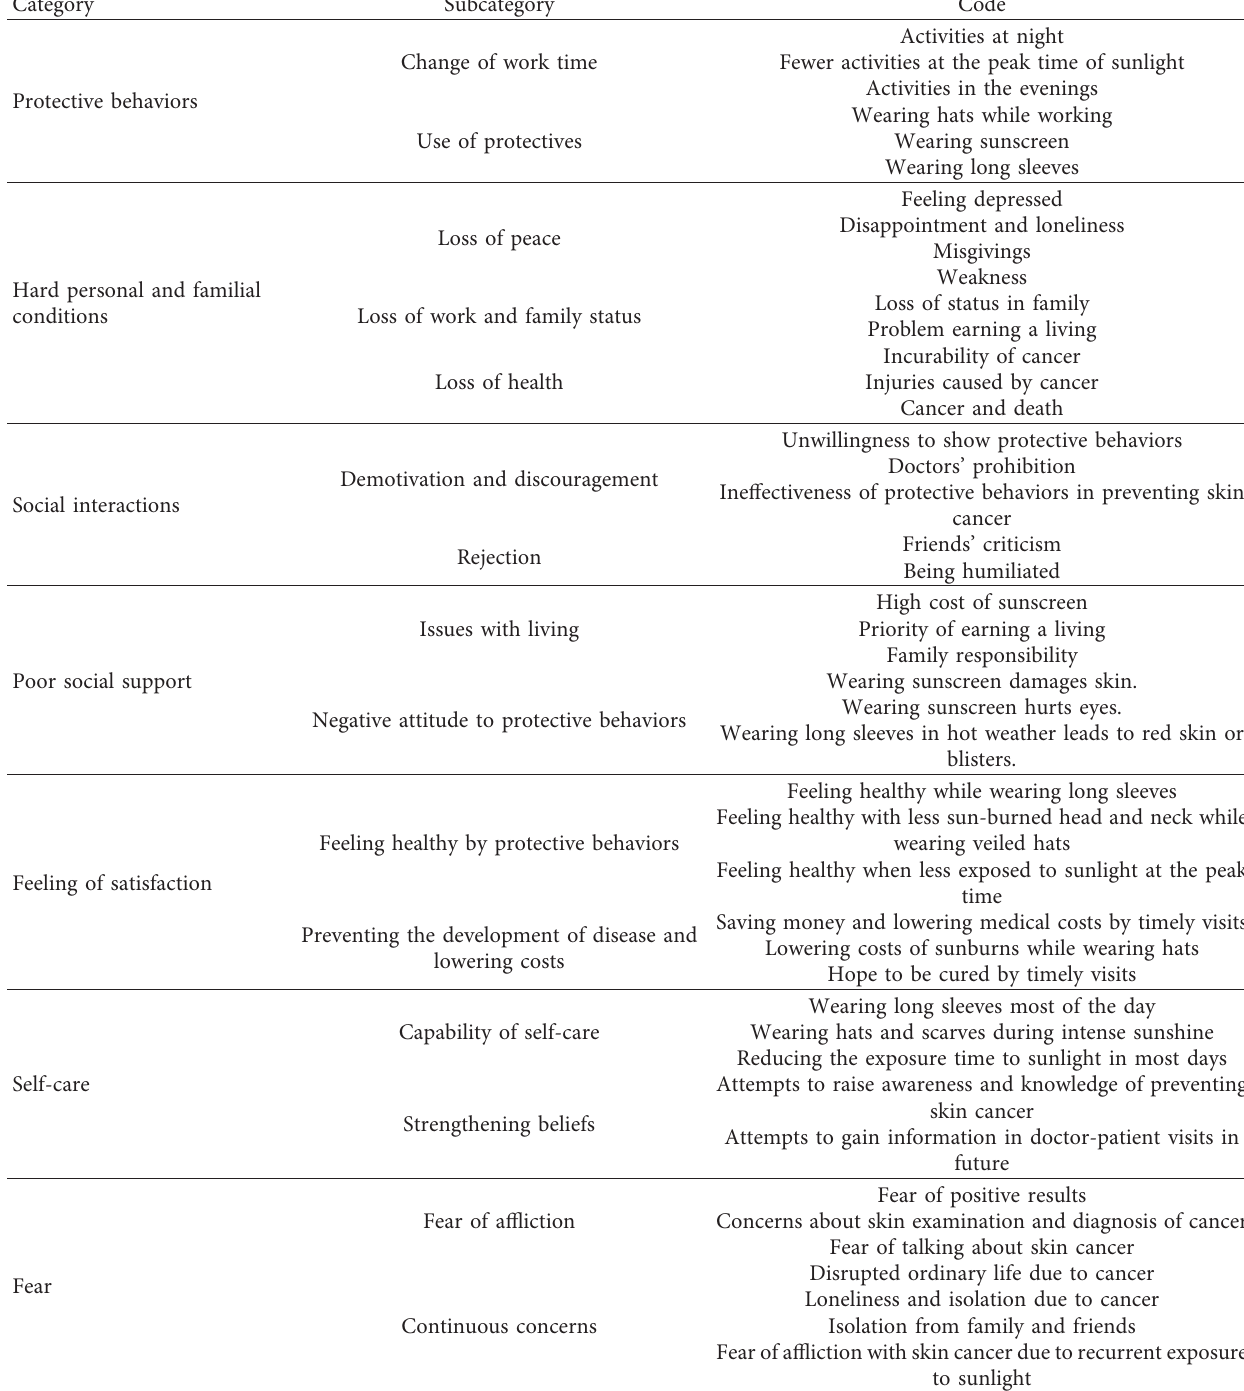
Table 2: Codes, categories, and subcategories of sailors’ perceptions and experiences of skin cancer and protective behaviors.